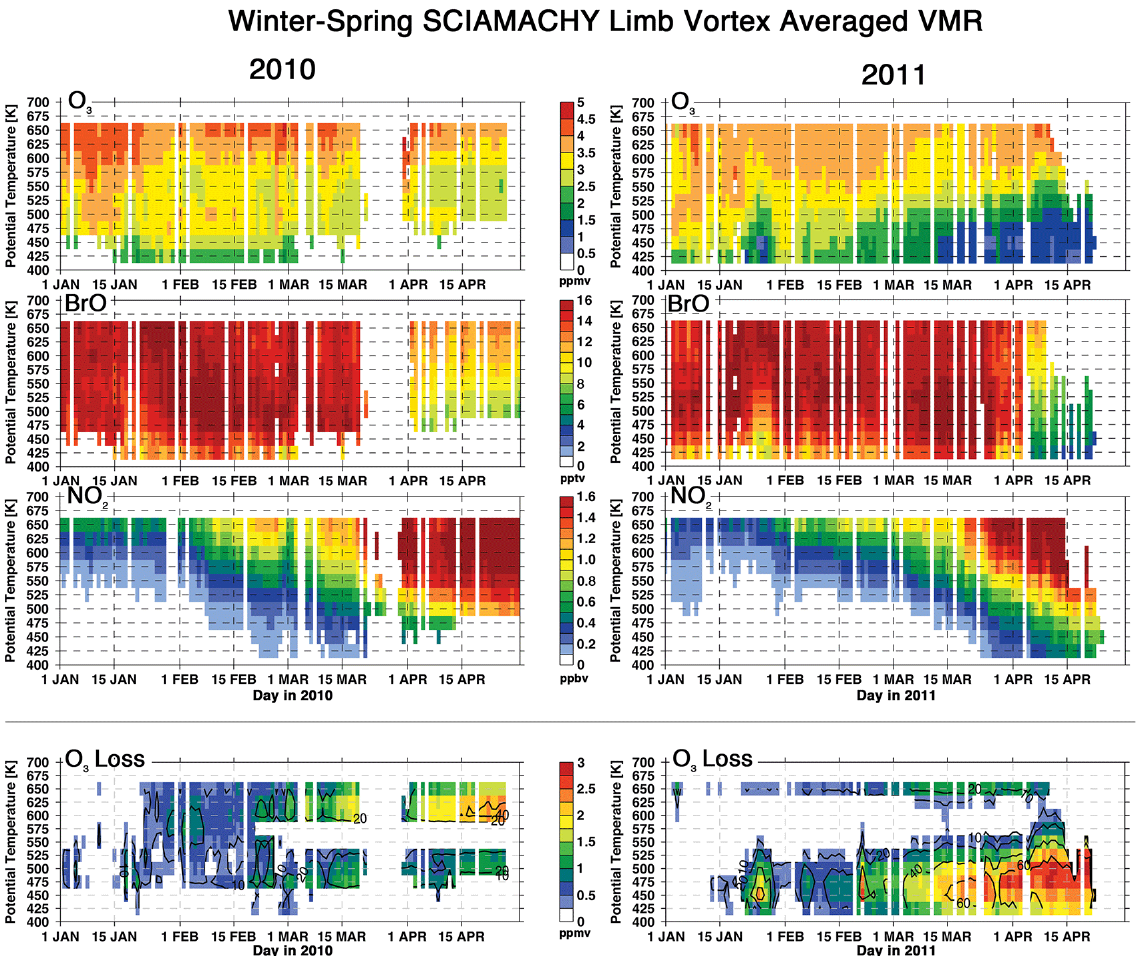
Fig. 5. Evolution of O 3 , BrO and NO 2 in the lower stratospheric Arctic polar vortex during the first 4 months of 2010 (left column) and 2011 (right column), obtained from SCIAMACHY limb observations. Bottom panels show corresponding chemical ozone losses obtained by using the method of Eichmann et al. (2002). Only those SCIAMACHY limb profiles are taken into account where the modified potential vorticity (UKMO) exceeds 38MPVU and the solar zenith angle is between 75 and 88 ◦ . Values from less than 10 samples have not been included and were blanked in the panels. Volume mixing ratios are colour shaded, black contour lines in the bottom panels denote relative ozone loss as